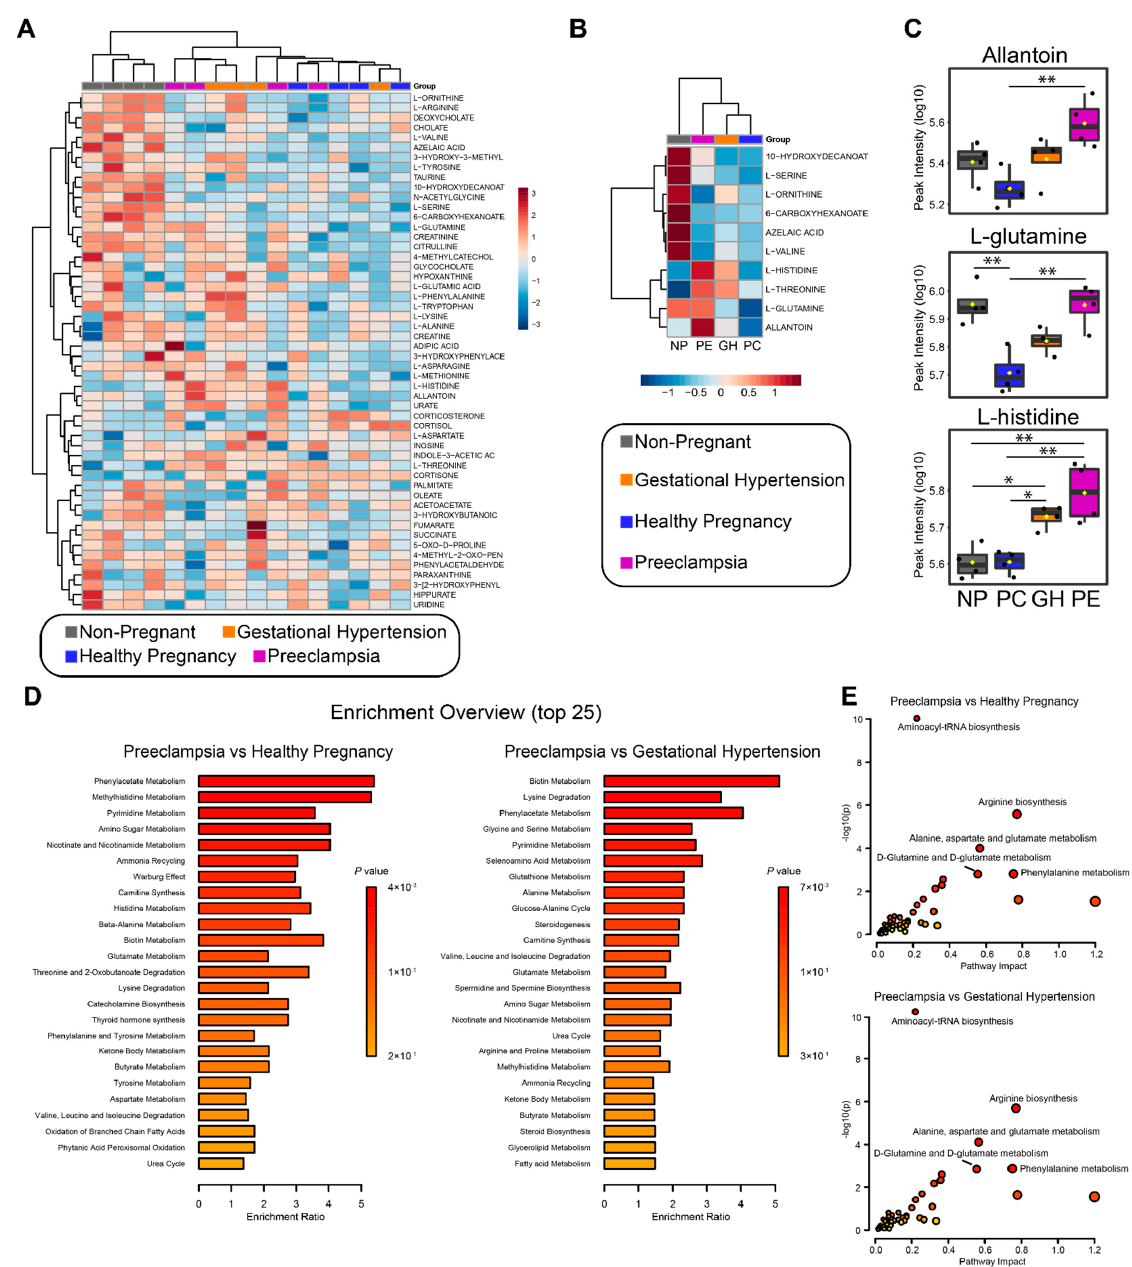
Figure 6. Metabolomics analysis from non-pregnant (NP), healthy pregnancy (PC), gestational hy- pertension (GH), and preeclampsia (PE) patients. Hierarchical clustering and heatmap of all the identified metabolites per sample ( A ) and the statistically changing metabolites as determined by ANOVA and Tukey’s HSD ( B ). Distance measure = euclidean and clustering algorithm = ward.D. ( C ) Allantoin, L-glutamine, and L-histidine intensity as determined by LC-MS and represented by boxplot. Statistical analysis performed with ANOVA and Tukey’s HSD. p < 0.05 (*) or p < 0.01 (**) were considered significant. ( D ) Quantitative enrichment analysis (QEA) of all the identified metabolites. Enrichment ratio was computed by hits/expected (hits = observed hits; expected = expected hits). ( E ) Joint-pathway analysis of the metabolomics and proteomics data. All the proteins and metabo- lites identified by each methodology were submitted to the analysis, along with their fold-change. Enrichment was performed via hypergeometric test, topology measure was set to degree centrality, and combined queries was the integration